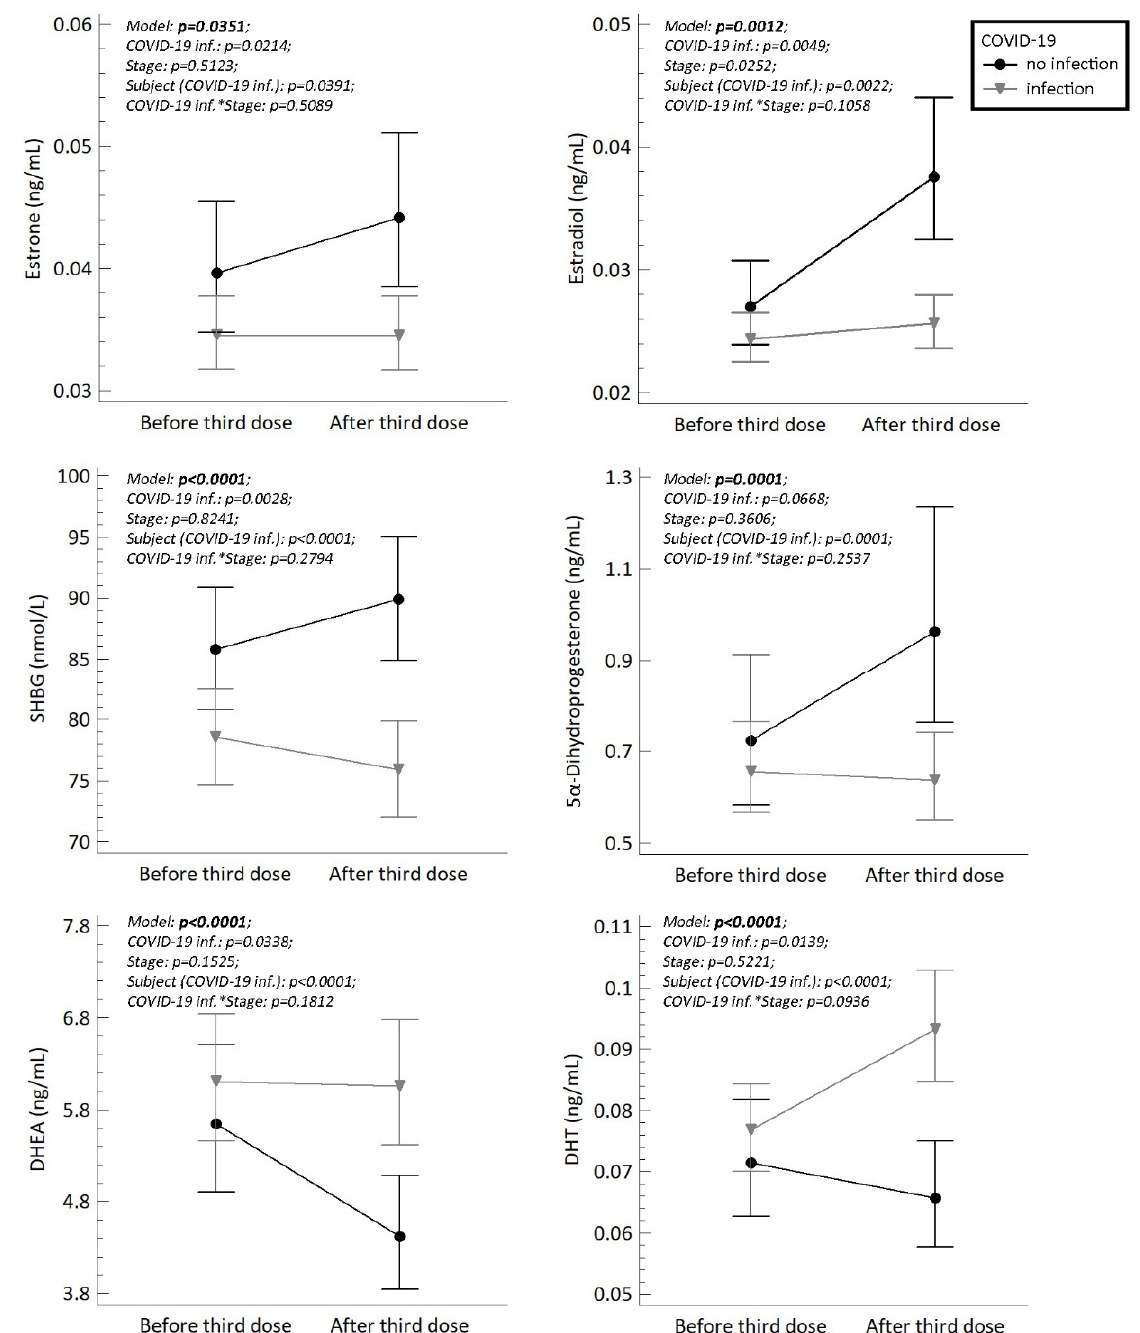
Figure 1. The plasma/serum levels of estrone, estradiol, SHBG (serum), 5 α -dihydroprogesterone, DHEA and DHT in fertile women (n = 25) who were reactive (indicating a prior COVID-19 infection) and non-reactive (no infection) to anti-SARS-CoV-2 antibodies before and after the third dose of COVID-19 vaccination. The symbols (circles and triangles) with error bars represent retransformed means with 95% confidence intervals computed using the least significant difference multiple com- parisons ( p < 0.05). Confidence intervals that do not overlap denote significant differences between the respective subgroups of means. Statistical significances ( p -values) are shown in each graph. Stage means status before or after third dose of vaccination. COVID-19 inf.*Stage represents the interaction between these